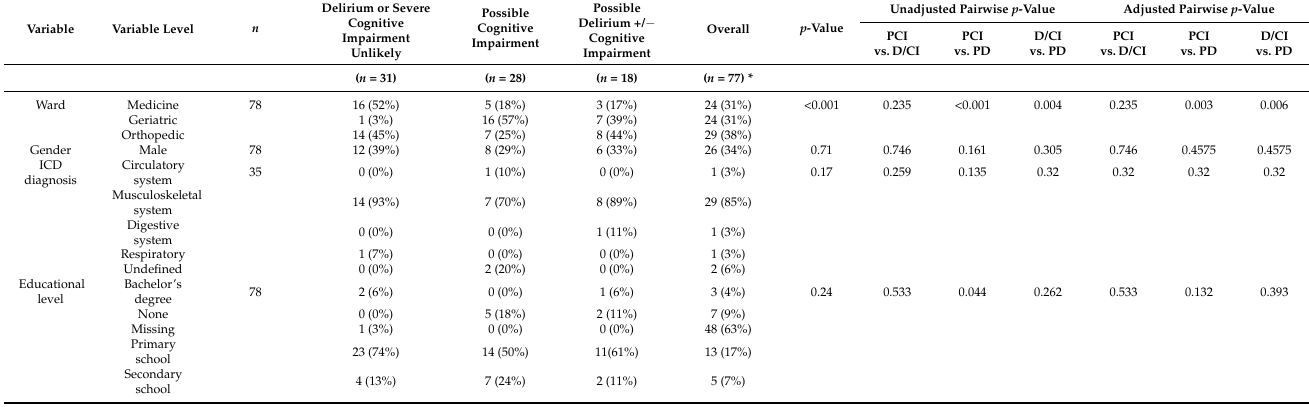
Table 1. Descriptive statistics of the whole sample according to the 4AT score profile group at baseline assessment. Categorical variables were summarized as relative and absolute frequencies. Pearson Chi-square test was used to assess differences across 4AT scale